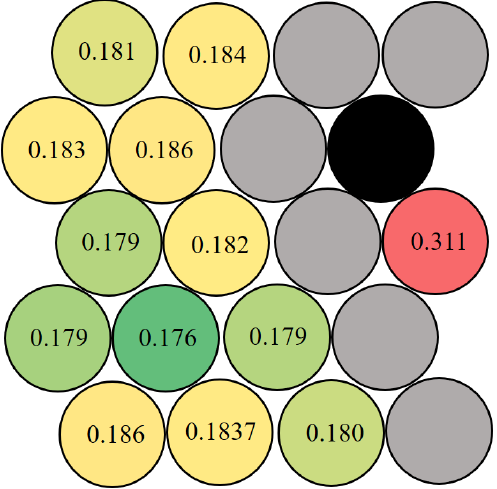
Figure 4. Results of the single cell measurement. Internal resistance in Ω